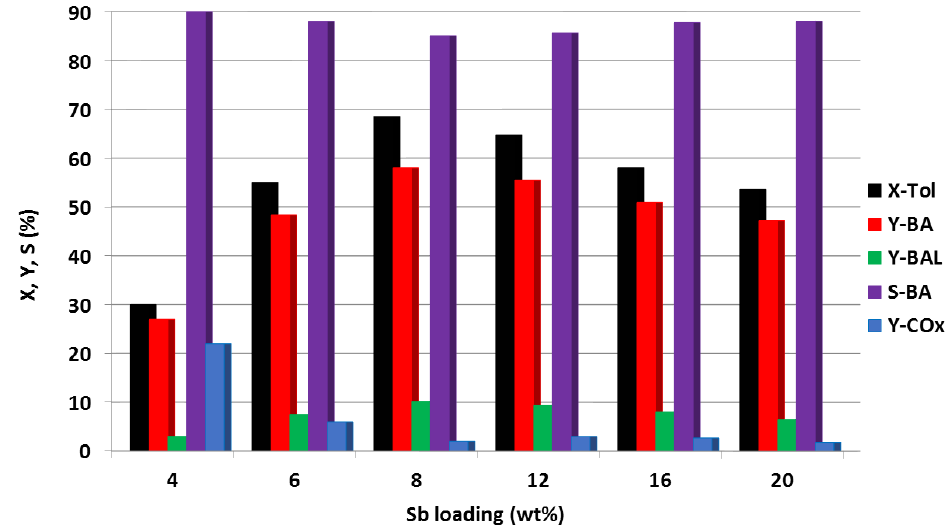
Figure 7. Effect of Sb loading on the catalytic performance of 10% Pd ‐ x % Sb/TiO 2 catalyst (Reaction conditions: Tol:AcOH:O 2 (air):Ar = 1:4:3(15):4; GHSV = 2688 h − 1 ; τ = 1.34 s; T = 210 °C; P = 2 bar) [80].